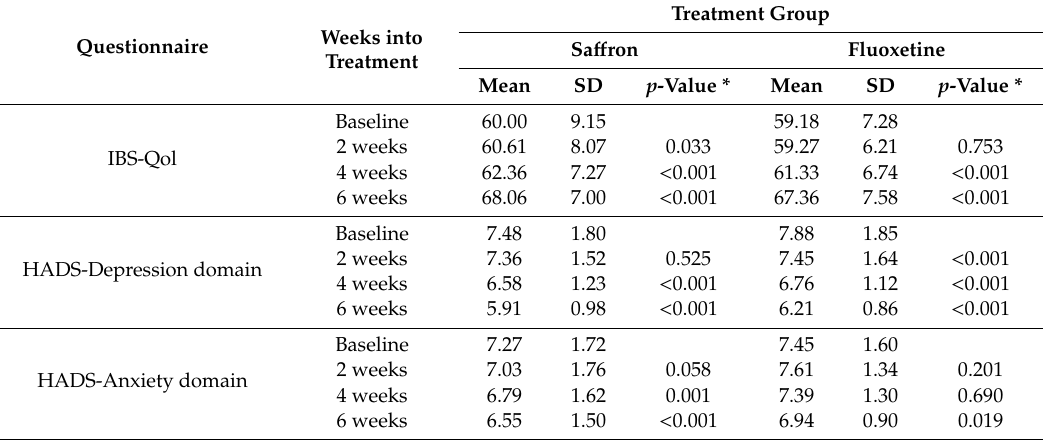
Table 1. Primary and secondary outcome measurements for the treatment with Sa ff ron vs.